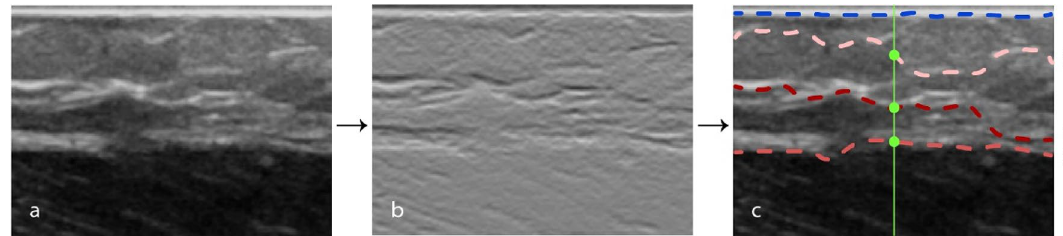
Figure 4. US feature extraction workflow. ( a ) Original US image of a fat layer on top of muscle measurement; ( b ) vertical gradient image; ( c ) result of applying the graph theory algorithm. The blue line represents the contact surface as selected by the graph theory, which is excluded from further analysis. The red lines represent the three best paths that were selected. The numbers indicate the selection order, with path 1 being the first path selected with the lowest cost. The green line represents the DRS measurement location in the center of the US image, with the feature extraction